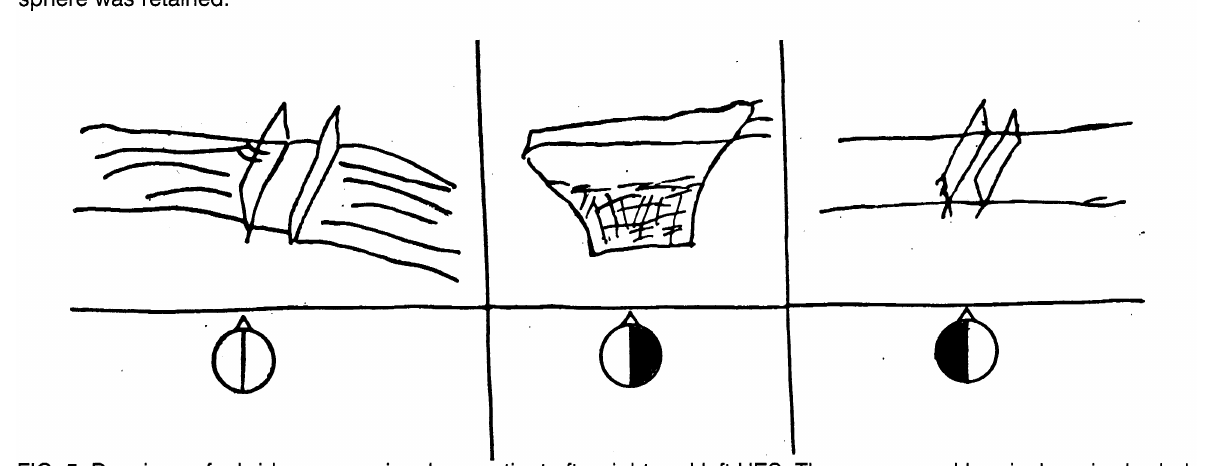
FIG. 5. Drawings of a bridge over a river by a patient after right and left UES. The suppressed hemisphere is